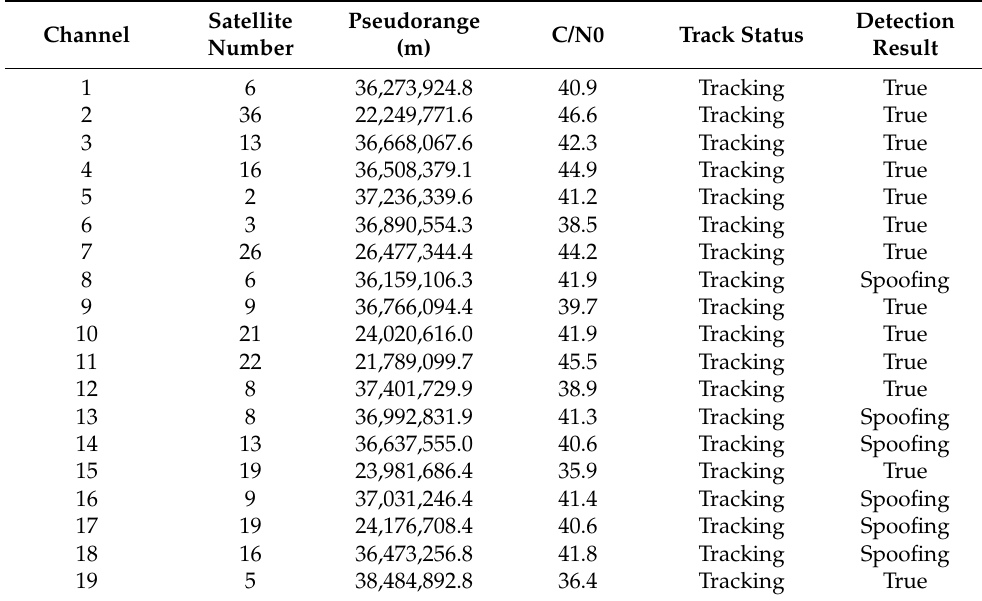
Table 1. Result of spoofing interference